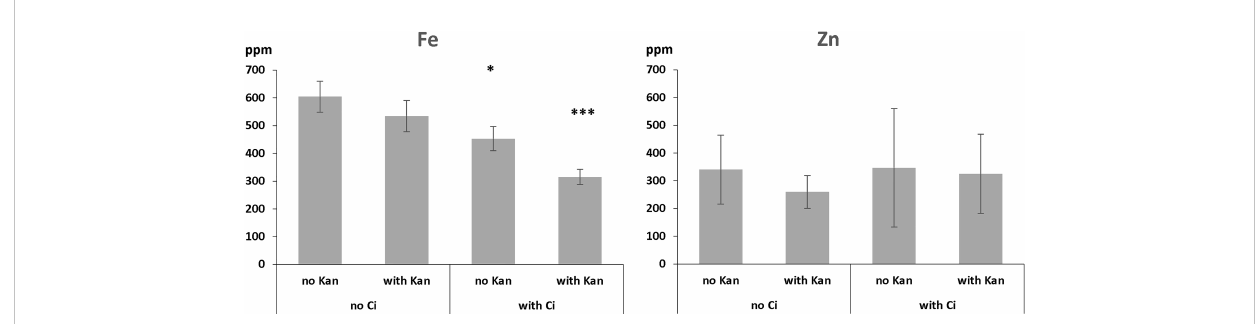
FIGURE 4 Iron and zinc concentrations in 10-days old control plants as affected by Ci, Kan and a combination thereof. ppm = part per million. Error bars represent standard deviation. * and *** indicate signi fi cantly different (p<0.05 and p<0.001 respectively) from control grown on medium without Ci and Kan (Student t